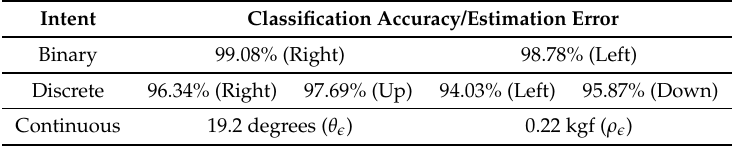
Table 3. User intent estimation depending on the desired shared-control